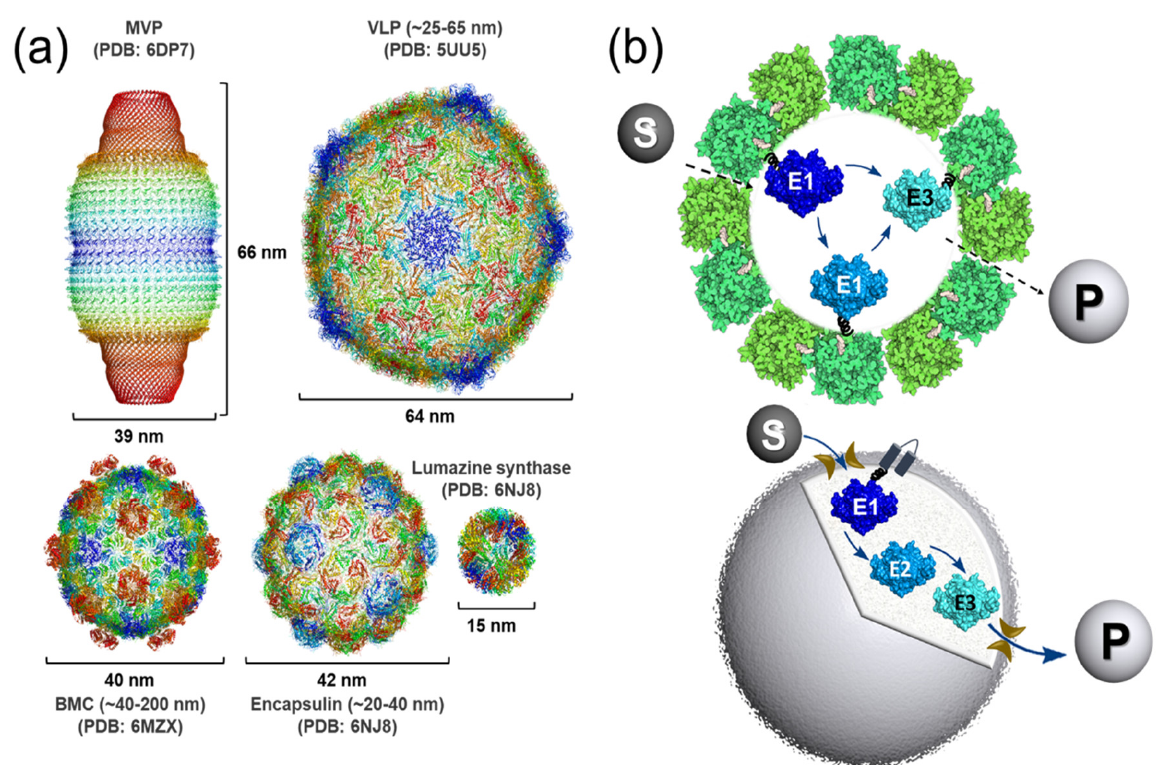
Figure 5. Compartmentalization strategies for multi-enzyme catalysis. ( a ) Representative examples of protein-based com- partments and their different sizes. Major vault particle from Rattus norvegicus , bacterial microcompartment from Haliangium ochraceum , encapsulin from Quasibacillus thermotolerans , lumazine synthase from Aquifex aeolicus and bacteriophage P22 virion capsid. ( b ) Encapsulation of multiple enzymes into porous protein shells via engineered targeting mechanisms (top) and enzyme encapsulation into synthetic polymersomes equipped with membrane channels and domains for enzyme cargo attachment. BMC: bacterial microcompartment shell. MVP, major vault protein; VLP, virus-like particle; BMC, bacterial microcompartment; PDB, protein data